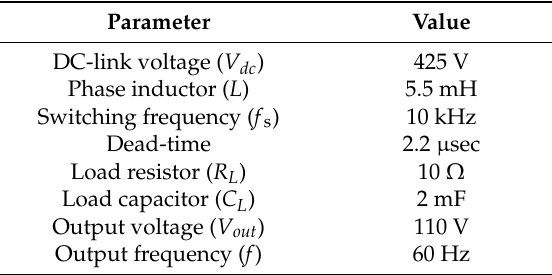
Figure 6. Photograph of the experimental setup. Table 2. Experimental parameters.